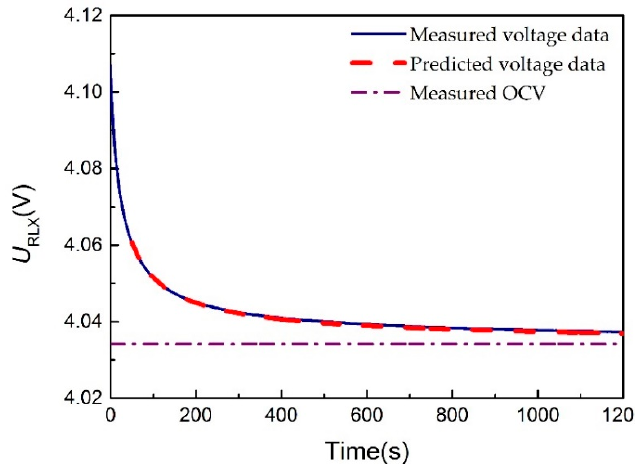
Figure 6. Verification of linear relationship between time coefficient and time.